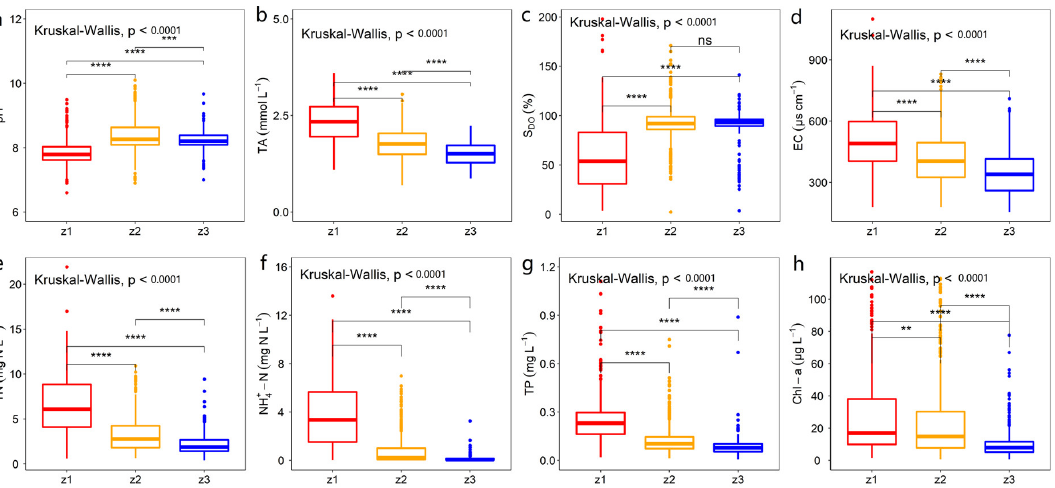
Figure 2. Spatial patterns in the key water parameters in different zones of Taihu Lake (non-parametric Kruskal–Wallis method). ( a ) pH; ( b ) TA: total alkalinity; ( c ) S DO : DO saturation; ( d ) EC: electric conductivity; ( e ) TN: total nitrogen; ( f ) NH 4+ –N: ammonium; ( g ) TP: total phosphorus; ( h ) Chl– a: chlorophyll a. **, ***, and **** respectively indicate the difference is significant at the p < 0.01, p < 0.001, and p < 0.0001 level, while ns indicated that the difference was non-significant. The numbers